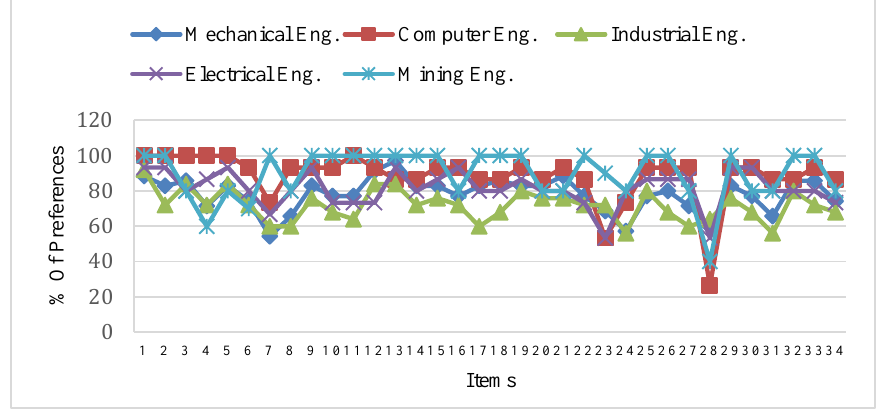
Fig. 3. Preferences of the different items related to the evaluation of the online training course in online EP by engineering